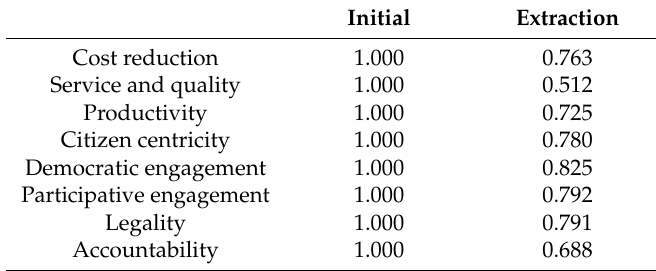
Table 12. Communalities.